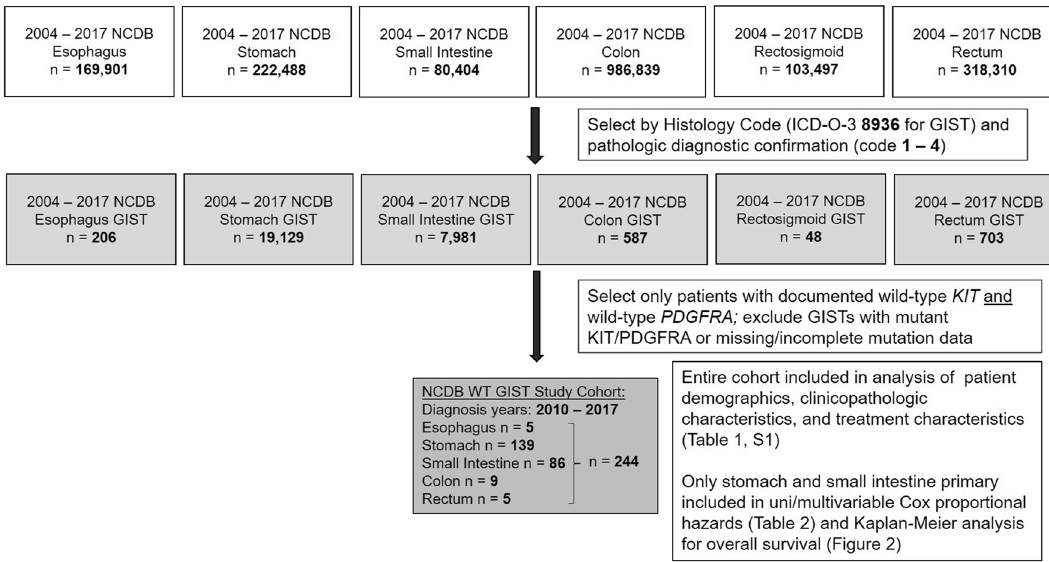
Figure 2. Flow diagram of patient selection from NCDB for this